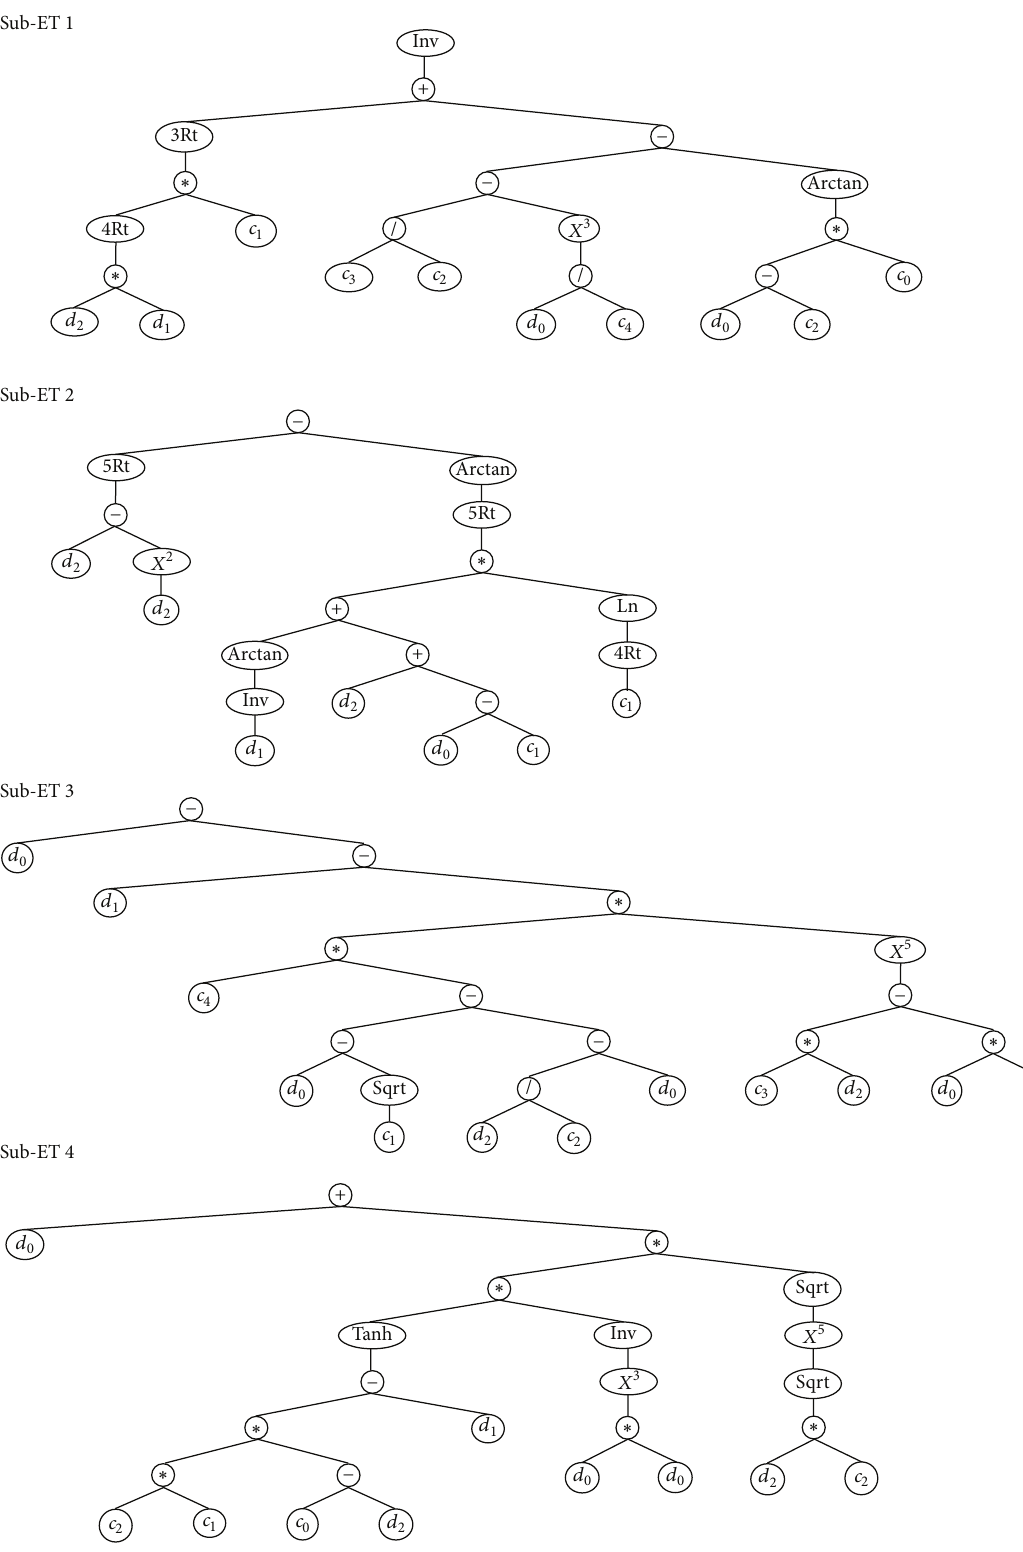
Figure 2: Expression tree for the GEP